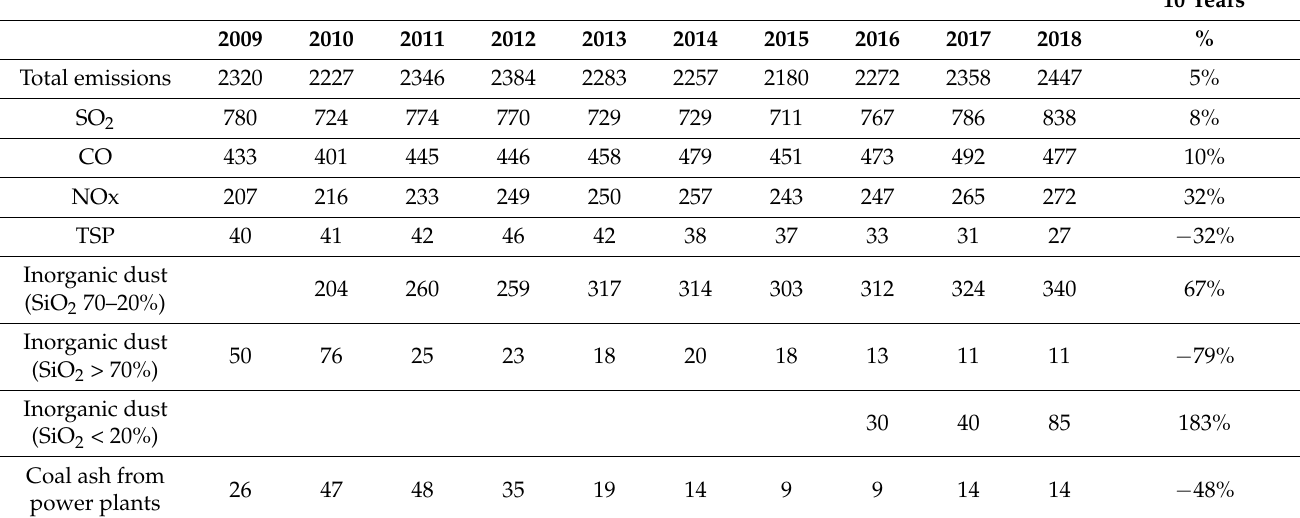
Change in Emissions over 10